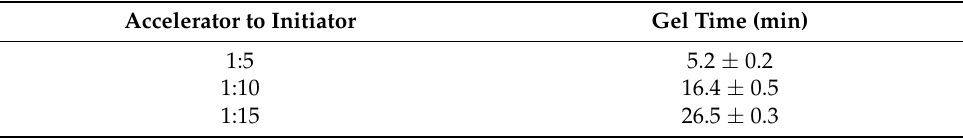
Table 2. Gel time of resin glue with different ratios of accelerator to initiator. Accelerator to